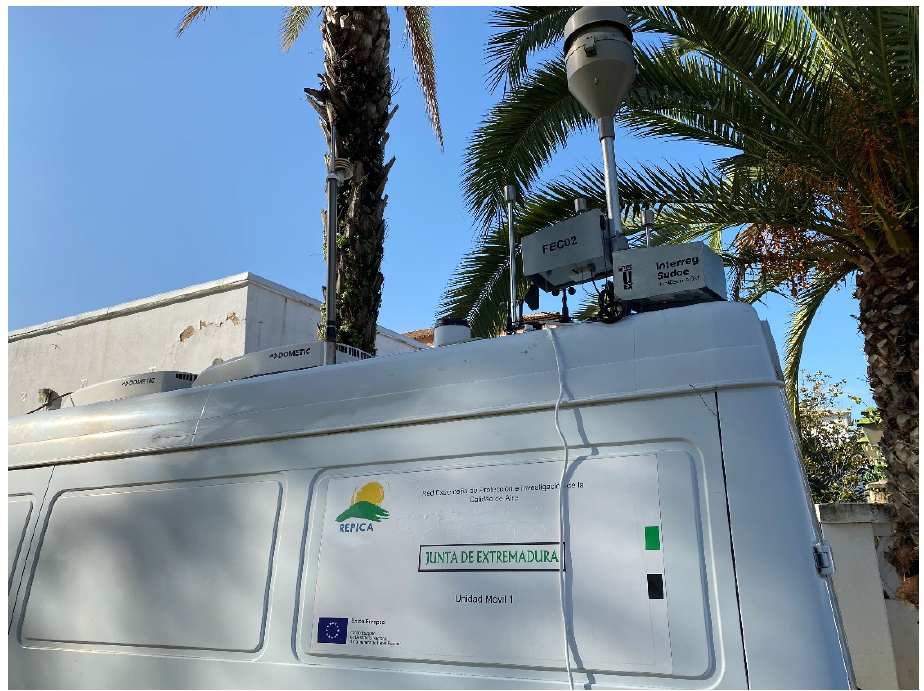
Figure 4. FEC01 and FEC02 installed in the reference mobile unit in Badajoz.